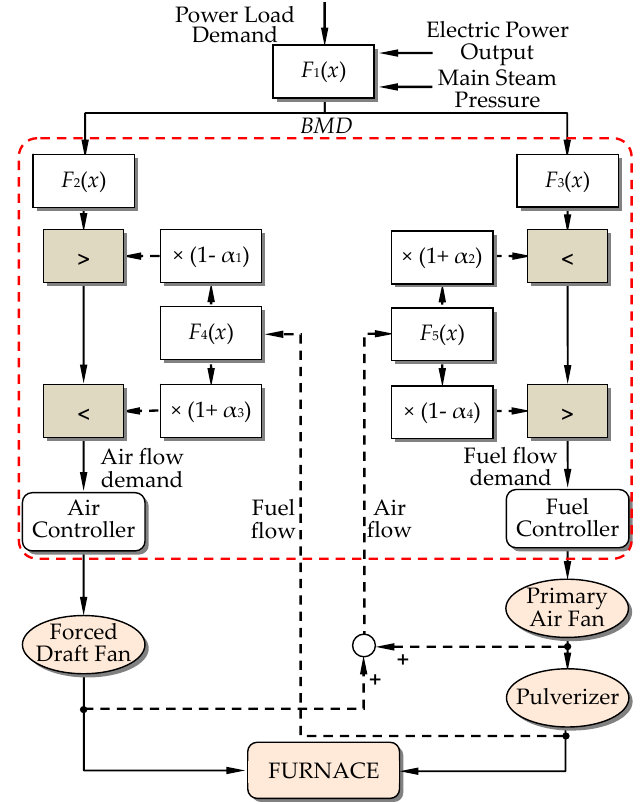
Figure 2. Typical power plant combustion with double cross-limiting strategy.